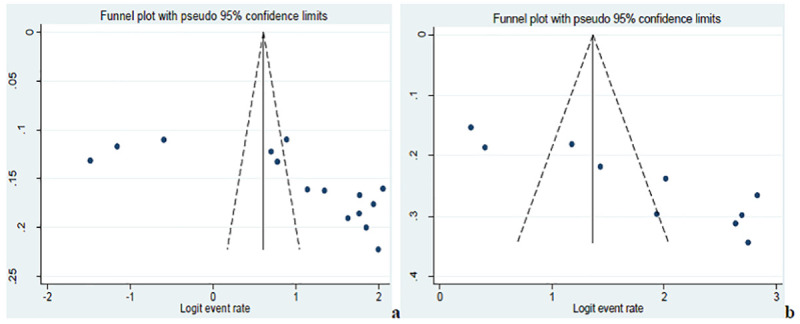
Funnel plots of the logit event rate of toxoplasmosis in pregnant women (a) and HIV infected (b).